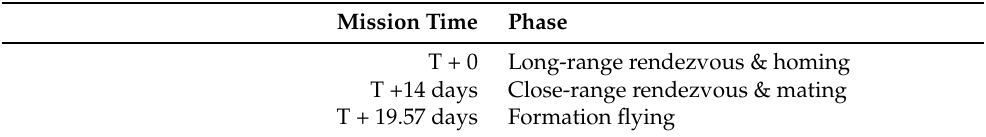
Table 8. Phases timeline for the Gateway re-supply mission.